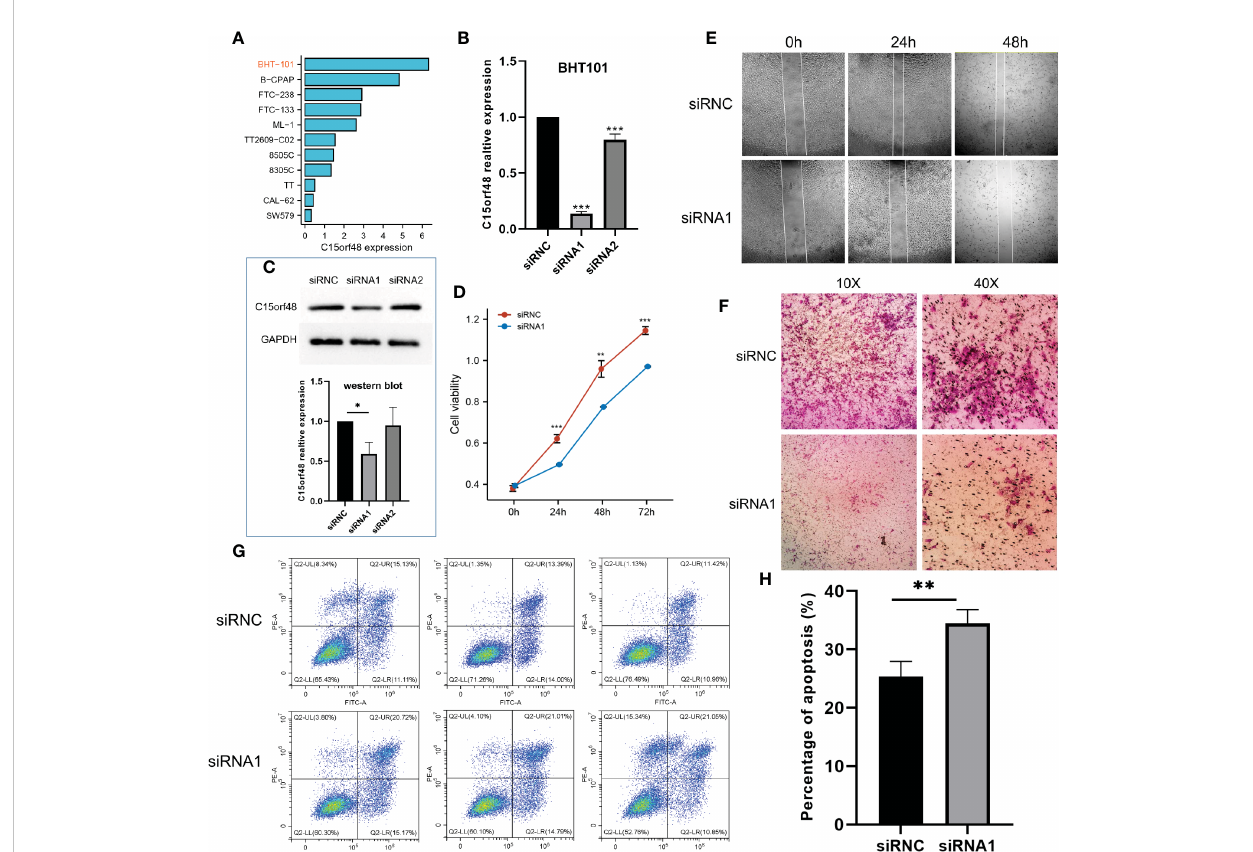
FIGURE 8 Effect of C15orf48 knockdown on THCA cell line BHT101, all experiments were performed in triplicate. (A) Expression levels of C15orf48 in different THCA cell lines; (B) RT-PCR veri fi cation of the knockout ef fi ciency of C15orf48 in BHT101 cells; (C) The knockout ef fi ciency of C15orf48 in BHT101 cells was veri fi ed by Western blot, and the fi gure below shows the statistical difference analysis of three repeated experiments; (D) CCK8 assay to analyze the effect of knocking out C15orf48 on cell proliferation; (E) Analysis of the effect of knocking out C15orf48 on cell healing ability by cell scratch test; (F) Transwell assay to analyze the effect of knocking out C15orf48 on cell migration; (G) Analysis of cell apoptosis changes by fl ow cytometry; (H) The percentage of apoptotic cells in the two groups. *P < 0.05; **P < 0.01; ***P <